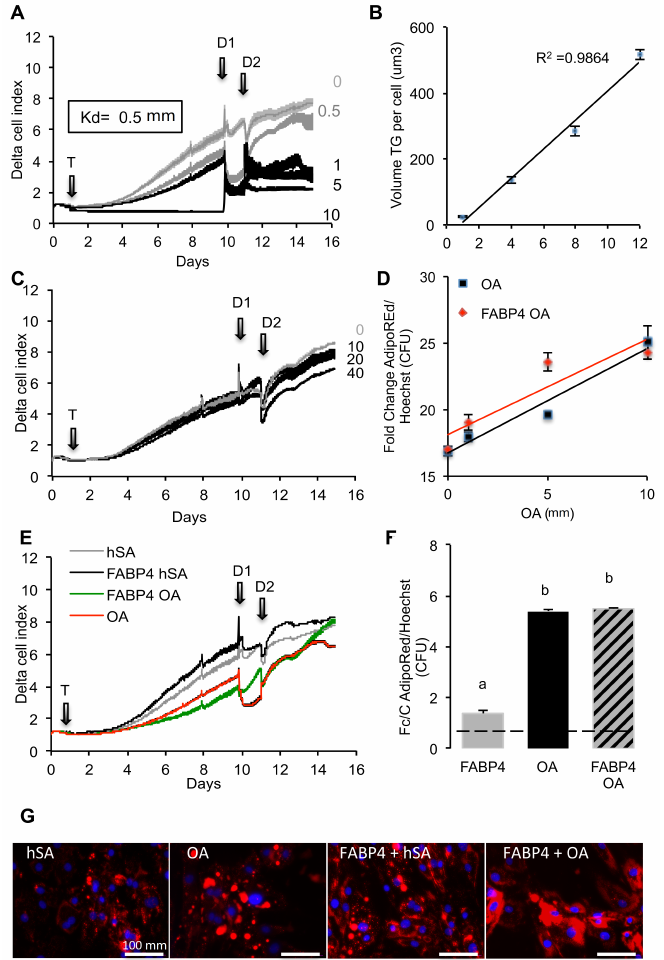
Figure 6. Extracellular Fatty acid binding protein 4 (FABP4) inhibits oleic acid (OA)-induced adi- pogenesis in human adipose stem cells (ASCs). At time (T) human ASCs were exposed during proliferation to OA complexed to human albumin (hSA) ( A , B ), recombinant FABP4 at several doses ( C , D ), or hSA 1%, OA 10 µ M and/or FABP4 20 ng/mL ( E – G ), then differentiation was induced (D1 and D2). The effect of OA on differentiation was revealed by the dose-dependent effect on cell adhesion force monitored as a cell index normalized at the time cells were loaded. ( A ) Real-time monitoring of cell index (representing adhesion force) shows the dose-dependent promoting effect of oleic acid on adipogenesis, i.e., reduction of cell adhesion force after induction of differentiation for OA doses up to 0.5 µ M, ( B ) validated by quantification at the end of the experiment of the mean droplet cell size (droplet count normalized to nuclei counts) on × 4 images. ( C ) Real-time monitoring of adipogenesis in presence of FABP4 at several doses shows no significant effect. ( D ) TG accumulation (AdipoRed fluorescence intensity normalized to cell number) due to OA uptake is independent of OA complexation to hSA versus FABP4. ( E ) Real-time monitoring of adipogenesis shows that although OA complexation to hSA improved adipogenesis (reduction of cell index after induction of differentiation), its complexation to FABP4 inhibited adipogenesis (an increase of cell adhesion after induction of differentiation), ( F ) without affecting accumulation of TG detected as described in ( D ). ( G ) Representative micrographs of merged Adipored (red) and Hoechst 33258 (blue) human cells at the end of experiments. Data are presented as mean +/ − SEM and letters represent significant differences (n = 8 biological replicates, ANOVA test, p < 0.05) in ( F